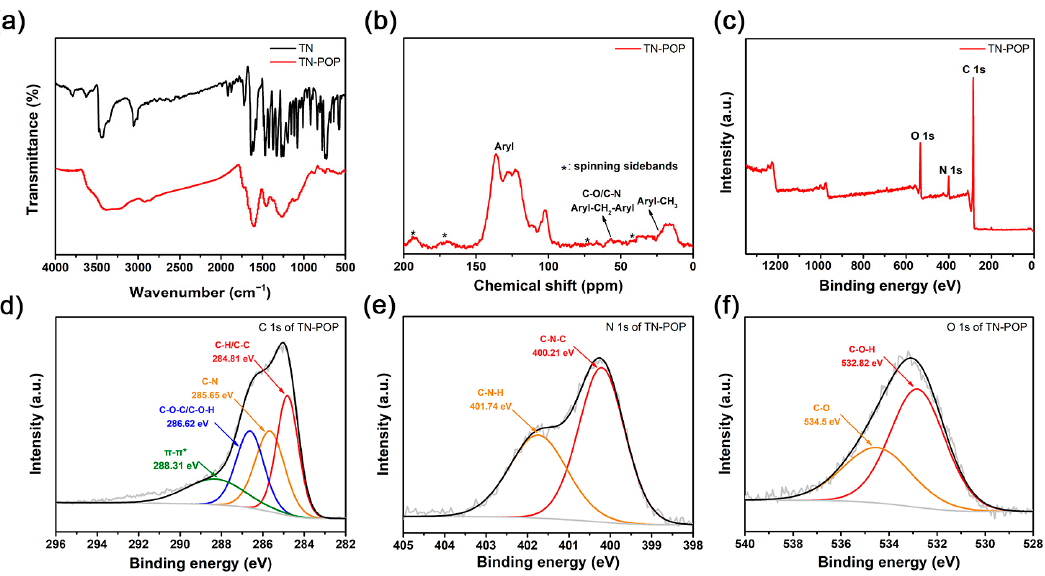
Figure 3. ( a ) FT-IR spectrum of TN and TN-POP; ( b ) Solid-state 13 C CP/MAS NMR spectrum of TN-POP; ( c ) XPS survey scan of TN-POP; ( d ) C 1s of TN-POP; ( e ) N 1s of TN-POP; ( f ) O 1s of TN-POP.